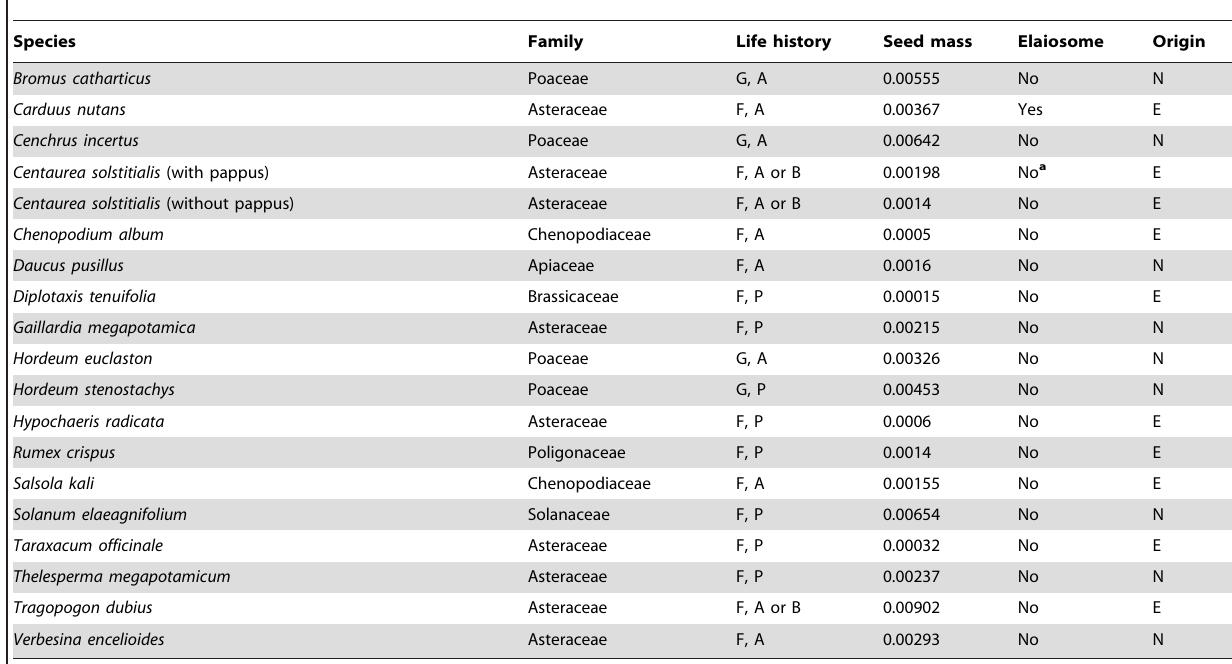
Table 1. A study species list with information on origin (N= native, E =exotic), mean seed mass (g), general life history characteristics (F= forb, G =grass, A=annual, B=biennial), and whether seeds have elaiosomes (fatty bodies attached to the seed that have evolved for ant seed